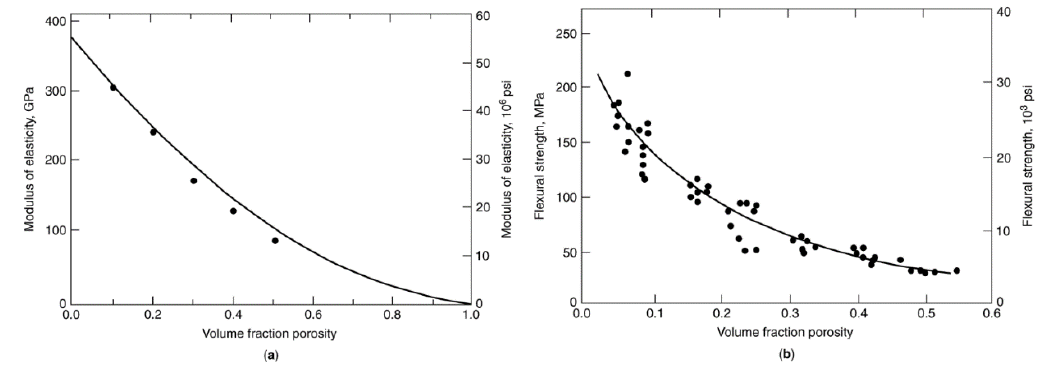
Figure 27. The influence of porosity on ( a ) the modulus of elasticity for aluminum oxide at room temperature and ( b ) the flexural strength for aluminum oxide at room